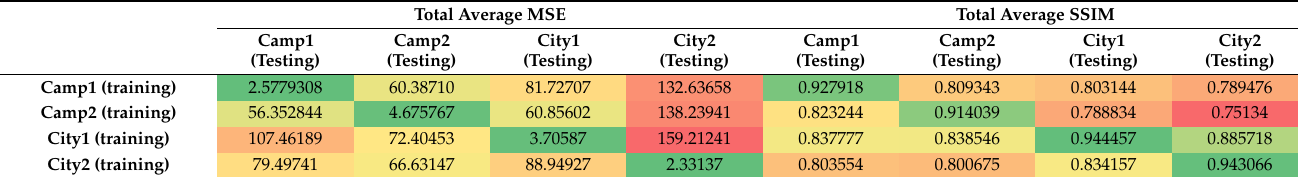
Table 1. Total average mean squared error (MSE) and structural similarity index (SSIM) values in each